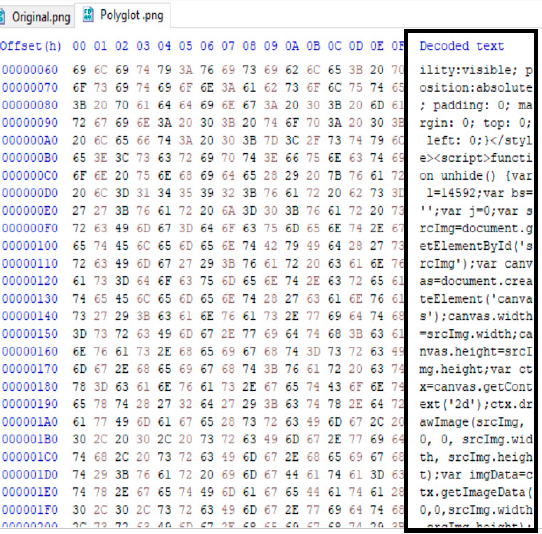
Figure 12. The polyglot image file structure is in hexadecimal view.